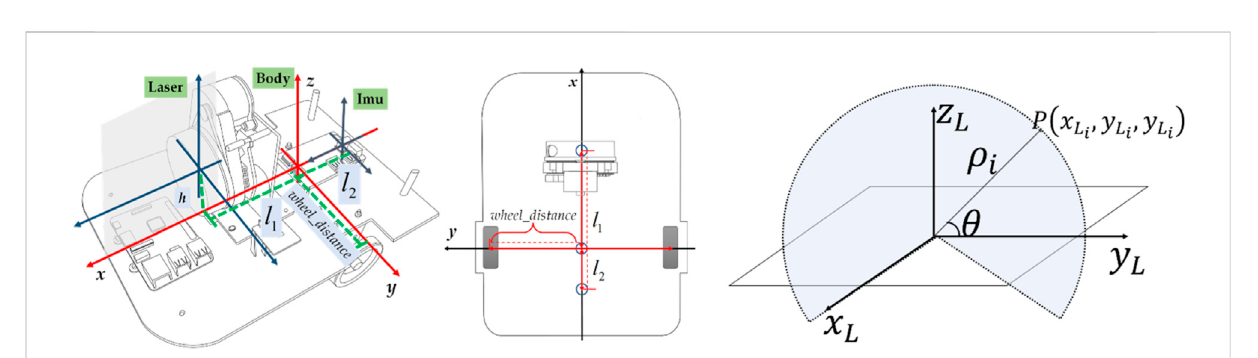
FIGURE 4 The schematic design and parameters of the 3D imaging